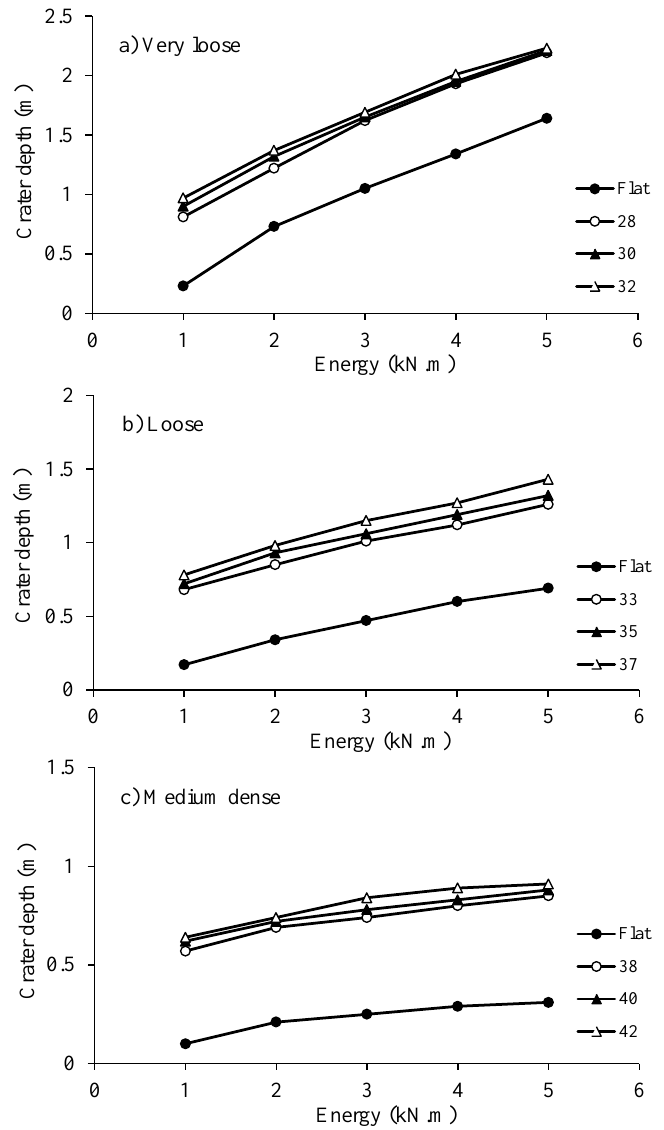
Fig. 7. Comparison of crater depths induced by tampers in different soil types